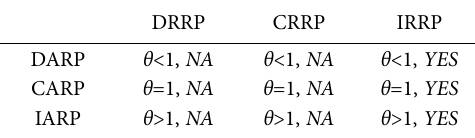
Table 2. Possible risk preferences under risk propensity ( θ >0, γ <0) DRRP CRRP IRRP DARP θ <1, NA θ <1, NA θ <1, YES CARP θ =1, NA θ =1, NA θ =1, YES IARP θ >1, NA θ >1, NA θ >1, YES “NA” stands for “Not Applicable” because the combi- nation of parameters’ signs produces always a posi- tive value of the derivative